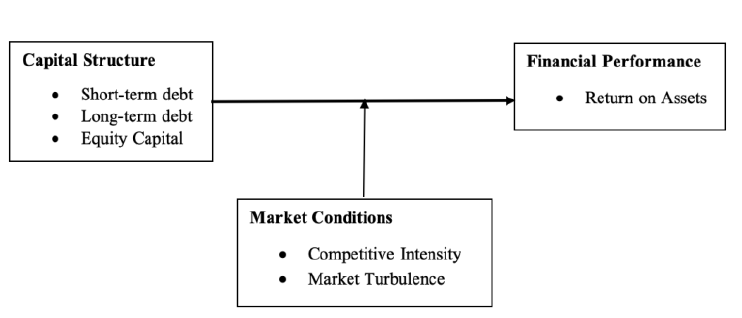
Figure 1: Conceptual Framework; Source: Researcher,